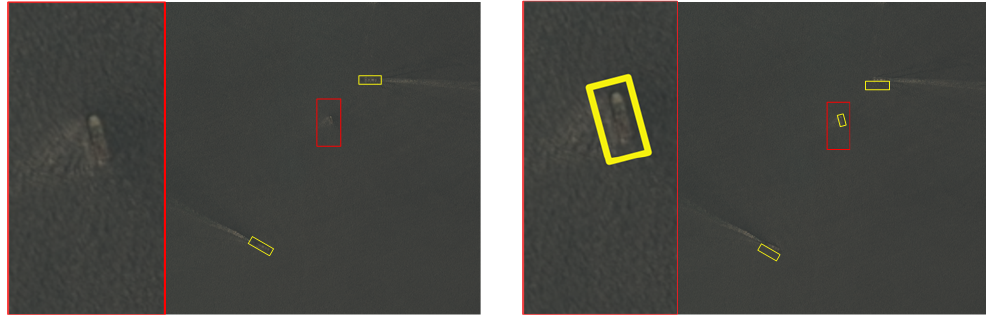
Figure 11. Comparison of detection results of small ships on the DOTA-GF dataset images ( left : RetinaNet method; right : our proposed method).